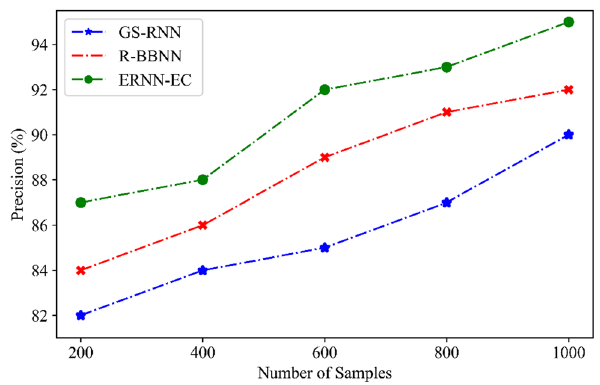
Figure 4: Comparison of precision.